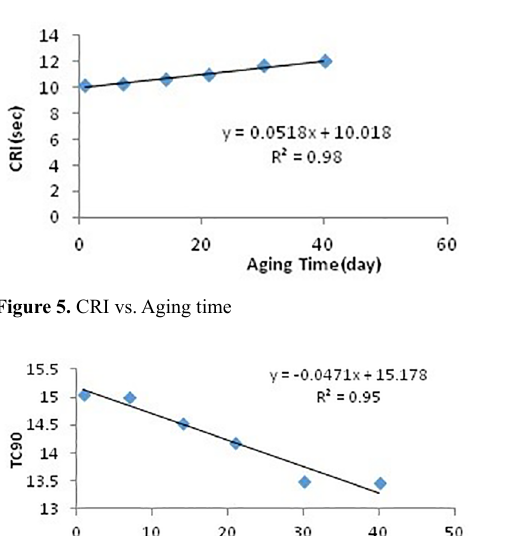
Table 5. Comparison between real aging time and predicted ones by TGA factor